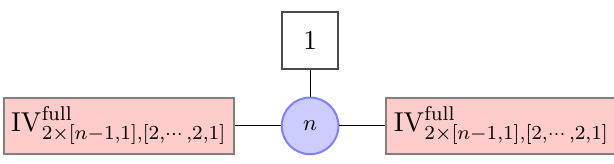
Figure 19 . Another weak coupling description of the type III AD theory associated with the Young diagrams Y 1 = Y 2 = [ n (cid:0) 1 ; n (cid:0) 1 ; 2] and Y 3 = [2 ; (cid:1) (cid:1) (cid:1) ; 2 ; 1 ; 1]. The left and right boxes